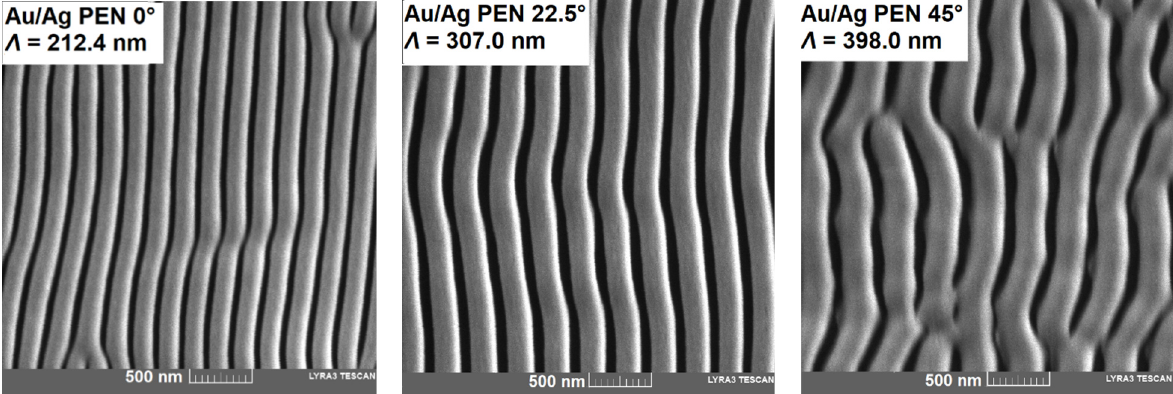
Figure 2. Micrographs from SE microscopy of Au/Ag PEN (0/22.5/45°) samples with corresponding values of periodicity ( Λ ).